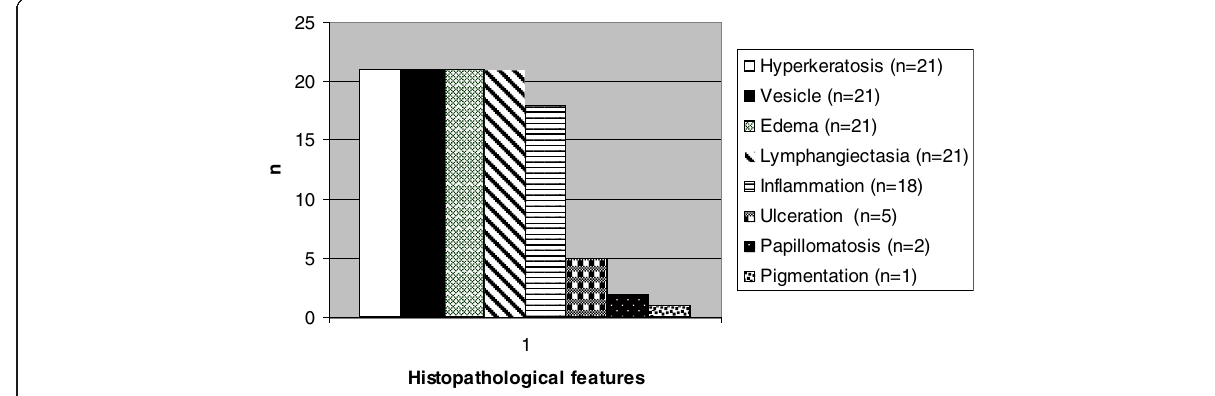
Figure 5 Histopathological properties of Kaposi sarcoma cases showing vesiculer pattern (n=21).